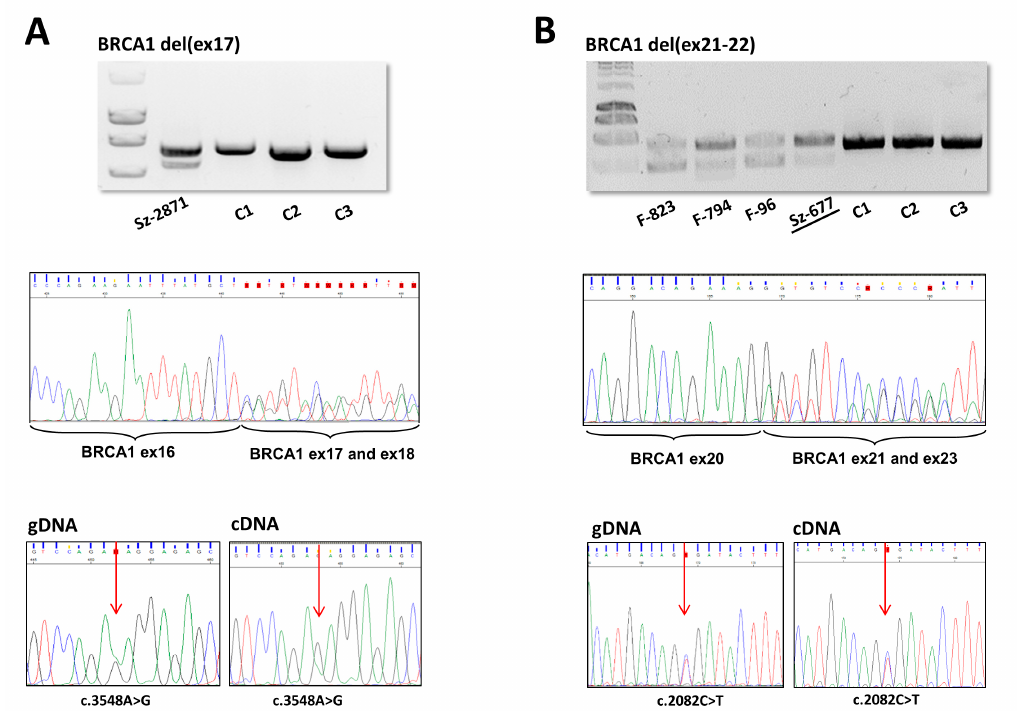
Figure 4. RT-PCR product, cDNA-level sequencing and allele expression ratio of ( A ): BRCA1 del(ex17) and ( B ): BRCA1 del(ex21-22) samples. PCR amplifications were done on